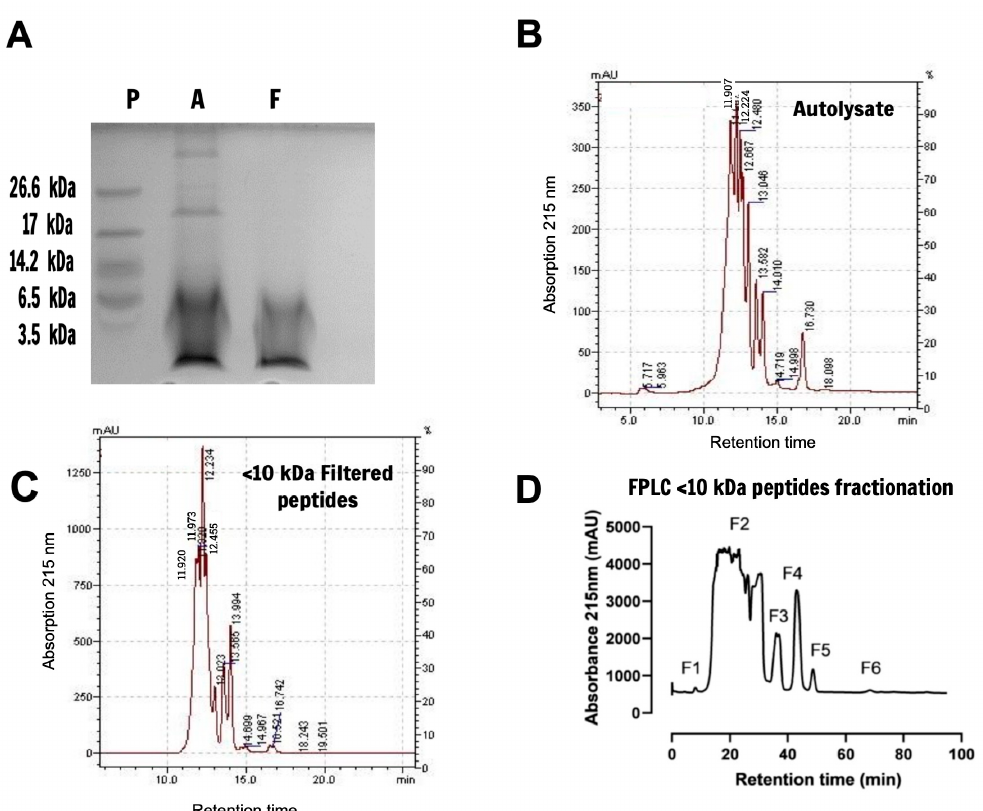
Figure 1. Yeast extract characterization and fractionation. ( A ) Tricine-SDS-PAGE 16% of about 70 µ g of the autolysate (lane A), filtered <10 kDa peptide extract (lane F), and ultra-low range molecular markers (lane P). Peptide bands, previously fixed with 5% glutaraldehyde, were visualized after staining with 0.025% Brilliant Blue G. ( B ) Fractionation of the protein/peptide content in the autolysate and ( C ) <10 kDa filtered peptide extract was performed employing an HPLC system coupled to a gel filtration ProSec300S column equilibrated with 0.05 M sodium phosphate buffer pH 7, and eluted in the same buffer containing 0.15 M NaCl at a flow rate of 1 mL/min. ( D ) 14.78 mg of the <10 kDa filtered peptides extract were fractionated using an FPLC Akta purifier system equipped with a Superdex-75/10 300GL column equilibrated and eluted with 0.05 M sodium phosphate buffer pH 7.0 at a constant flow of 0.8 mL/min. Absorbances were monitored at 215 nm, and fractions